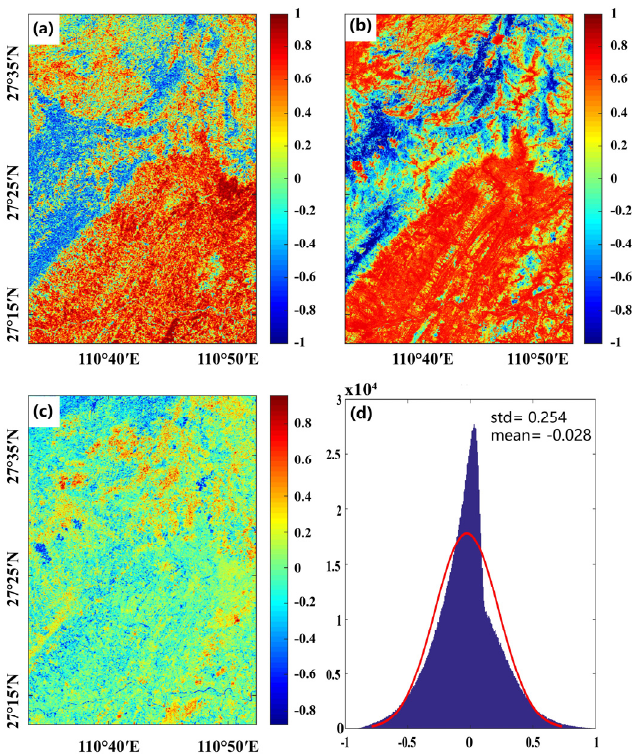
Figure 6. ( a ) True coherence in Longhui area. ( b ) Estimated coherence by the model in Longhui area. ( c ) Differences between the true and estimated coherences. ( d ) Histogram of the differences.